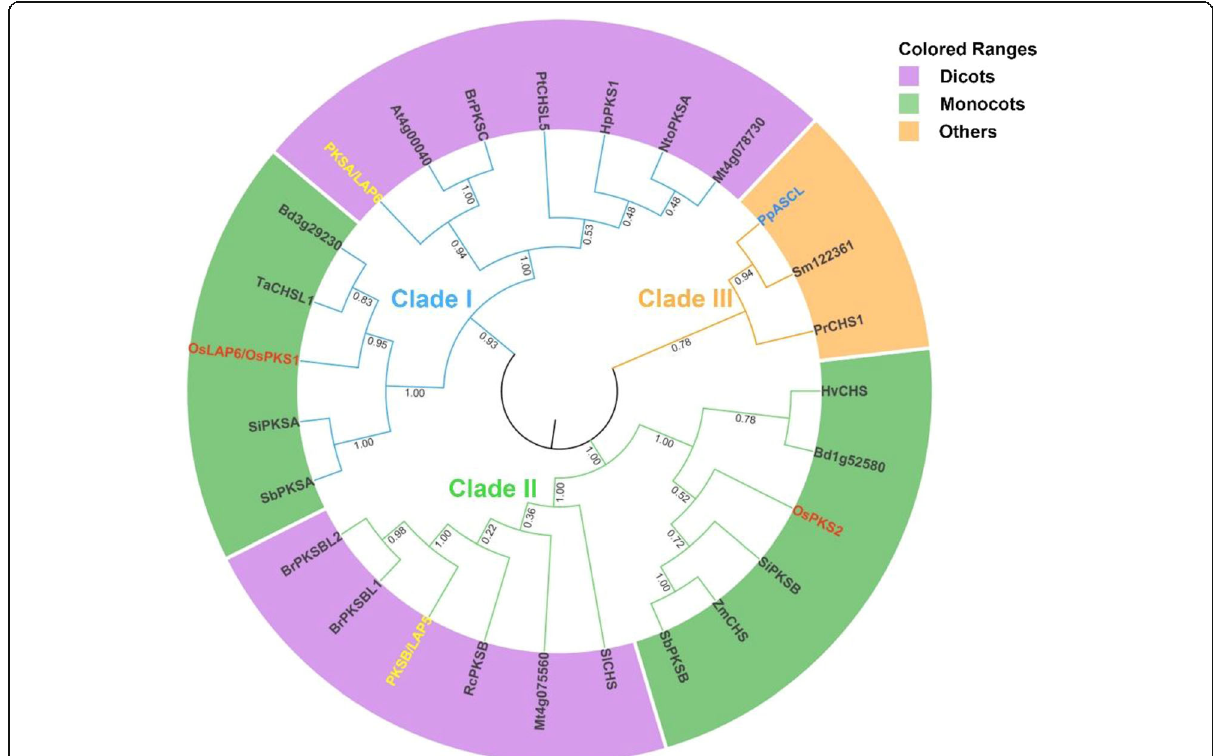
Fig. 7 Protein phylogeny analysis among OsLAP6/OsPKS1-related proteins. A Neighbor-Joining phylogeny analyses was performed using MEGA5, based on the alignment results in Additional file 1: Figure S4. The OsLAP6/OsPKS1-related proteins are clearly grouped into three clades. The proteins in clades I and II belong to the homologous proteins of PKSA/LAP6 and PKSB/LAP5 groups, respectively. The numbers at the nodes indicate the bootstrap value. The detailed information of OsLAP6/OsPKS1-related proteins are listed in Additional file 2: Table